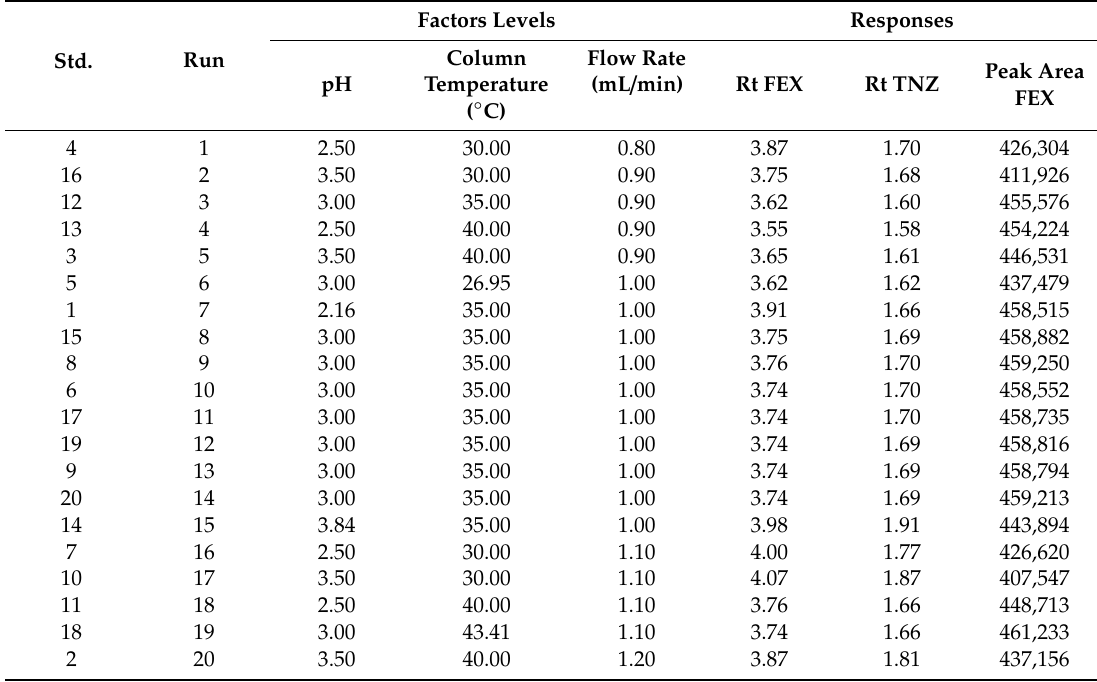
Table 4. Experimental domain of two-level CCD of HPLC assay optimization for three factors and measured